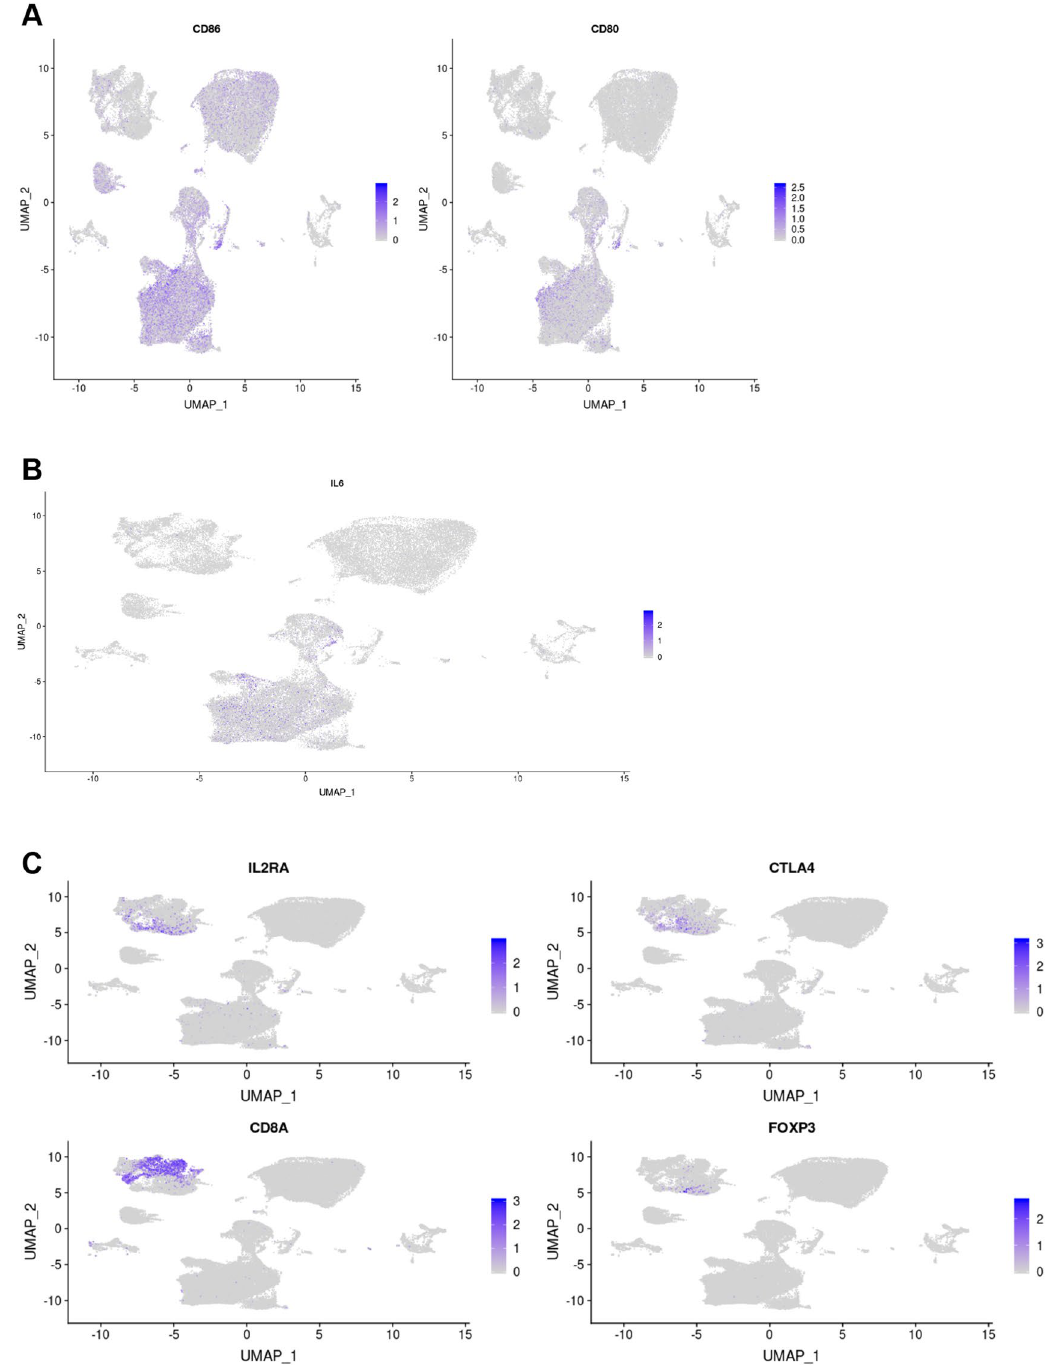
Figure 6. Expression of the cell-type specific markers defining the cell clusters representing the three elements of the CD80/86 axis. ( A ) Expression of co-stimulatory protein genes CD80 and CD86, and targets of abatacept. While CD86 has a more ubiquitous expression (including both alveolar and tissue infiltrating macrophages), CD80 is specifically expressed in FCN1+ monocyte-derived macrophages. ( B ) IL6 expression is circumscribed to the clusters of activated macrophages. ( C ) Cell markers representing activated T cells (CTLA4, IL2RA), CD8+ lymphocytes (CD8A) and Tregs (FOXP3 and IL2RA). CTLA4 expression was enriched in the CD4+ T cell cluster number